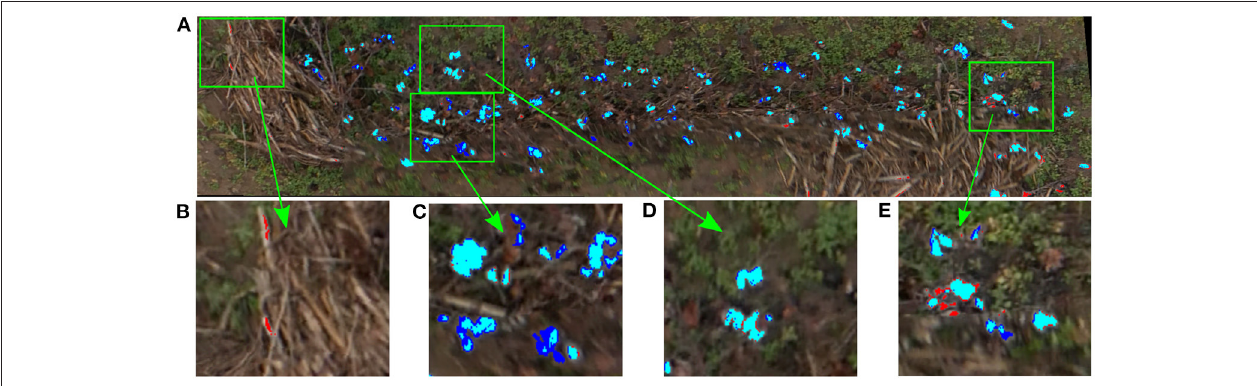
FIGURE 7 | Inference results of the SVM classifier on the training plot image. Blue pixels were missed by the classifier (Type II errors); red pixels were misclassified as cotton by the classifier (Type I errors); cyan were correctly classified cotton pixels, (A) Training plot image classification results, (B) Non-cotton pixels misclassified as cotton (Type I errors), (C) Cotton boll pixels not fully detected (Type II errors), (D) Cotton boll pixels fully correctly detected, (E) Type I and Type II errors mixed together.